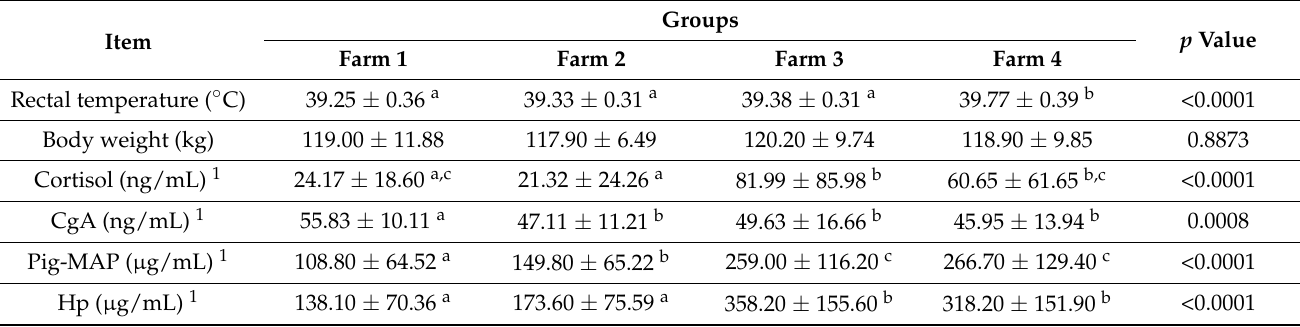
Table 1. Pigs’ mean rectal temperature, body weight and plasma concentration of cortisol, CgA and acute-phase proteins measured at four farms with different biosecurity scores.